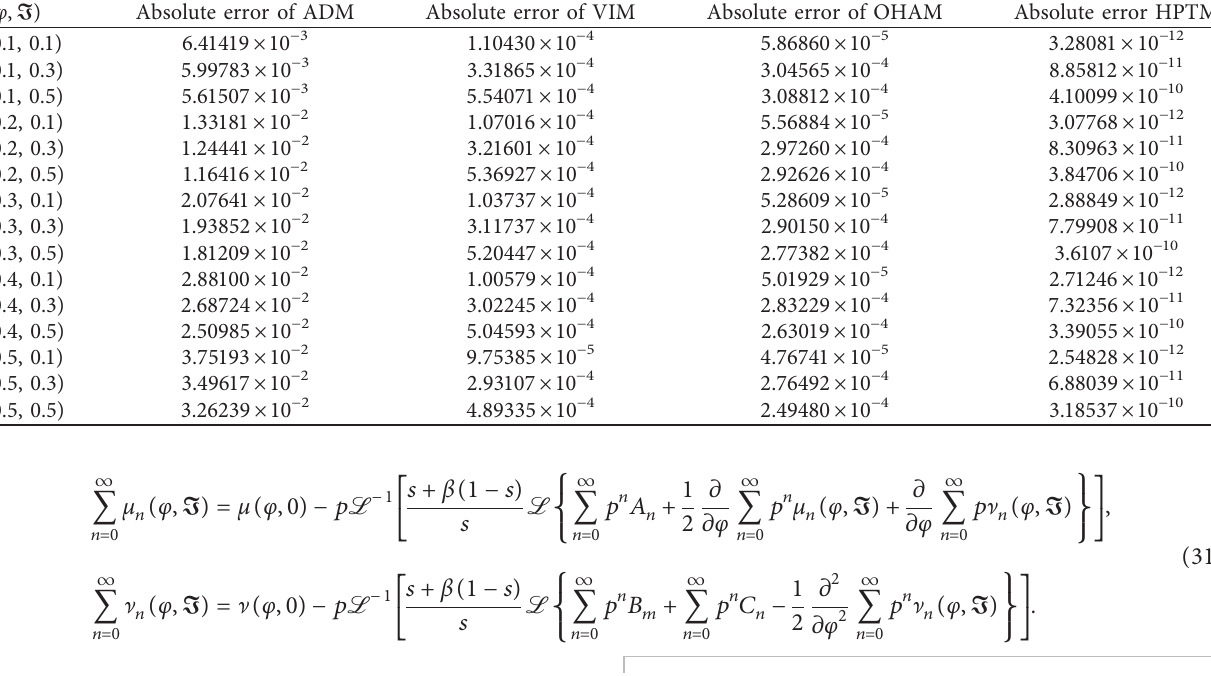
Table 4: Comparison of different methods for the approximate solution of Example